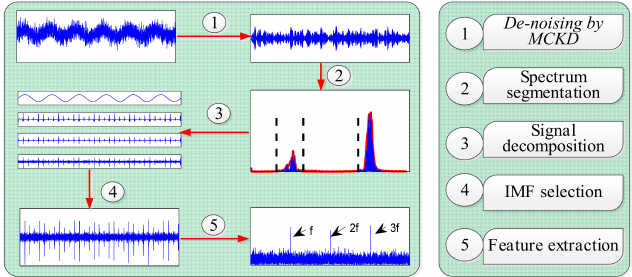
Figure 1. Flowchart of the proposed